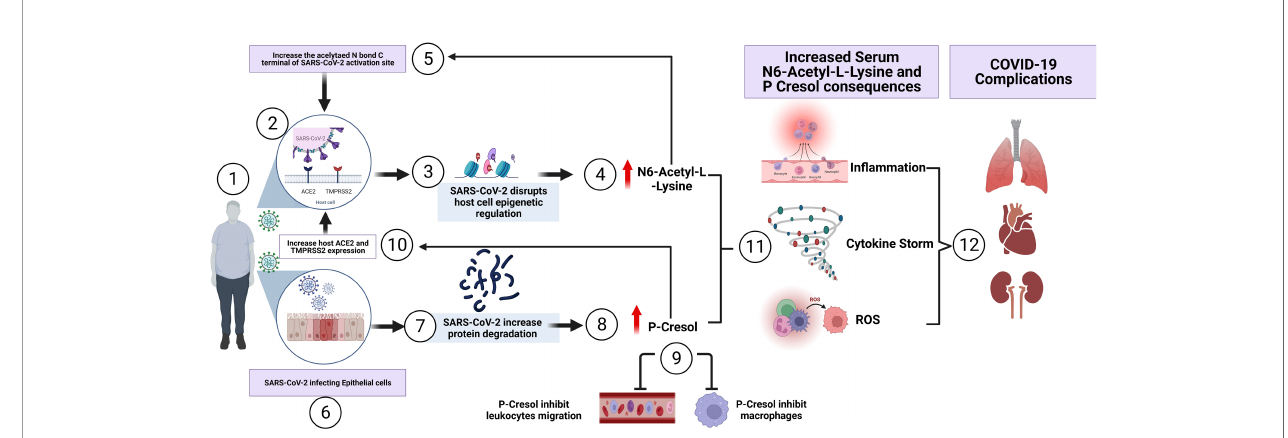
FIGURE 5 | Summary of the proposed involvement of N6-Acetyl-L-Lysine and p-Cresol as key metabolites of COVID-19 pathogenesis observed in COVID-19 overweight-obese patients. (1) SARS-CoV-2 access the airway of an overweight-obese patient by binding to the host cell. (2) The virus utilizes ACE2 receptor for its entry and the serine protease TMPRSS2 for S protein priming, contributing to rapid spread of the virus in infected patients. (3) Inside the host cell, SARs- CoV-2 in fl uence epigenetic factors that manipulates viral survival and replication, leading to metabolic dysregulation. (4) The increase of N6-Acetyl-L-Lysine, as a key metabolite of COVID-19 pathogenesis in overweight-obese patients, induces molecular alterations in SARS-CoV-2 Nucleoplasmid and RNA at functional interacting sites. This in turn creates a positive feedback loop through the induction of viral replication and infectivity. In another mechanism, (5) and (6) SARS- CoV-2 invasion of epithelial cells, leads to the (7) degradation of proteins and thus accumulating as a by-product toxin. Of these, is the uremic toxin (8) P-Cresol, another key metabolite involved in the pathogenesis of COVID-19 disease, displayed increased intensity in overweight-obese COVID-19 patients. Elevated p- Cresol (9) is shown to inhibit macrophage activity and leukocyte cell adhesion, which leads to decrease of immune response, as seen in COVID-19 patients. (10) In another mechanism, p-Cresol increases the expression of ACE2 receptor and TMPRSS2, thus enhancing viral entry and load. (11) The increase of N6-Acetyl- L-Lysine and p-Cresol resulted in the induction of in fl ammation, cytokine storm and reactive oxygen species (ROS) production. This subsequently led to the development of (12) severe health complications which involves pulmonary fi brosis, cardiovascular diseases and kidney failure, and possibly admission to intensive care unit